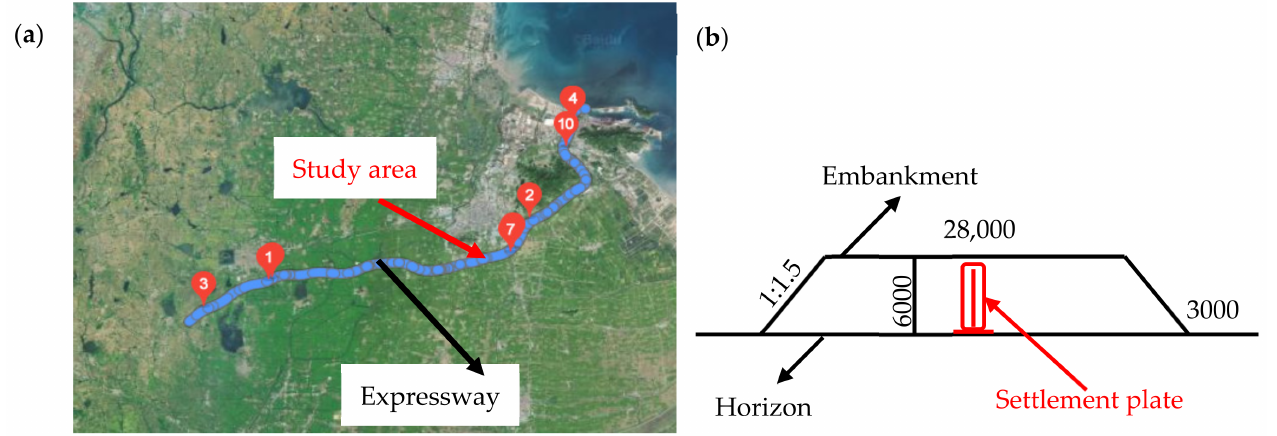
Figure 3. Expressway location and schematic diagram of embankment settlement observation. ( a ) Location and study area of Expressway. ( b ) Schematic diagram of embankment cross-section and settlement monitoring (the unit of measurement is mm).